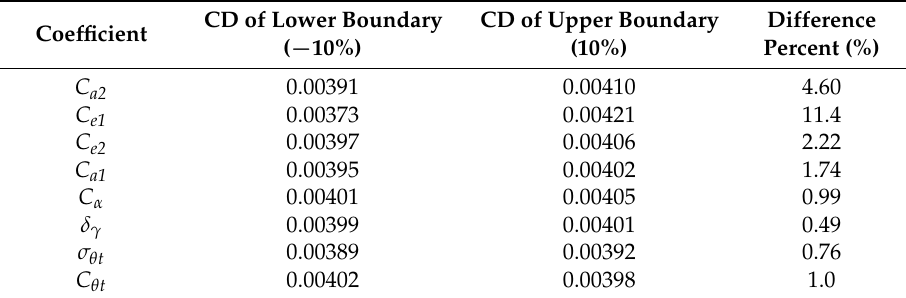
Table 1. The sensitivity analysis of each model coefficient.